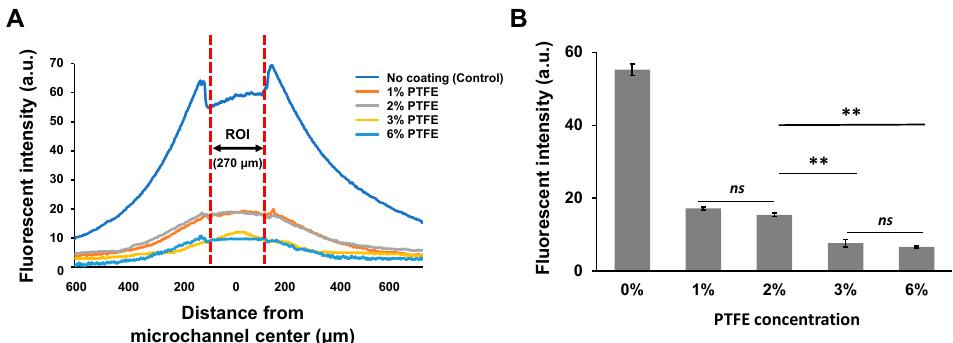
Figure 5. ( A ) Fluorescent intensity profile of the microchannels coated with different PTFE concentrations after 20 min of incubation with Nile red. ( B ) Average fluorescent intensity of the region of interest (ROI) with different PTFE coating concentrations (** p < 0.01, ns: not significant).